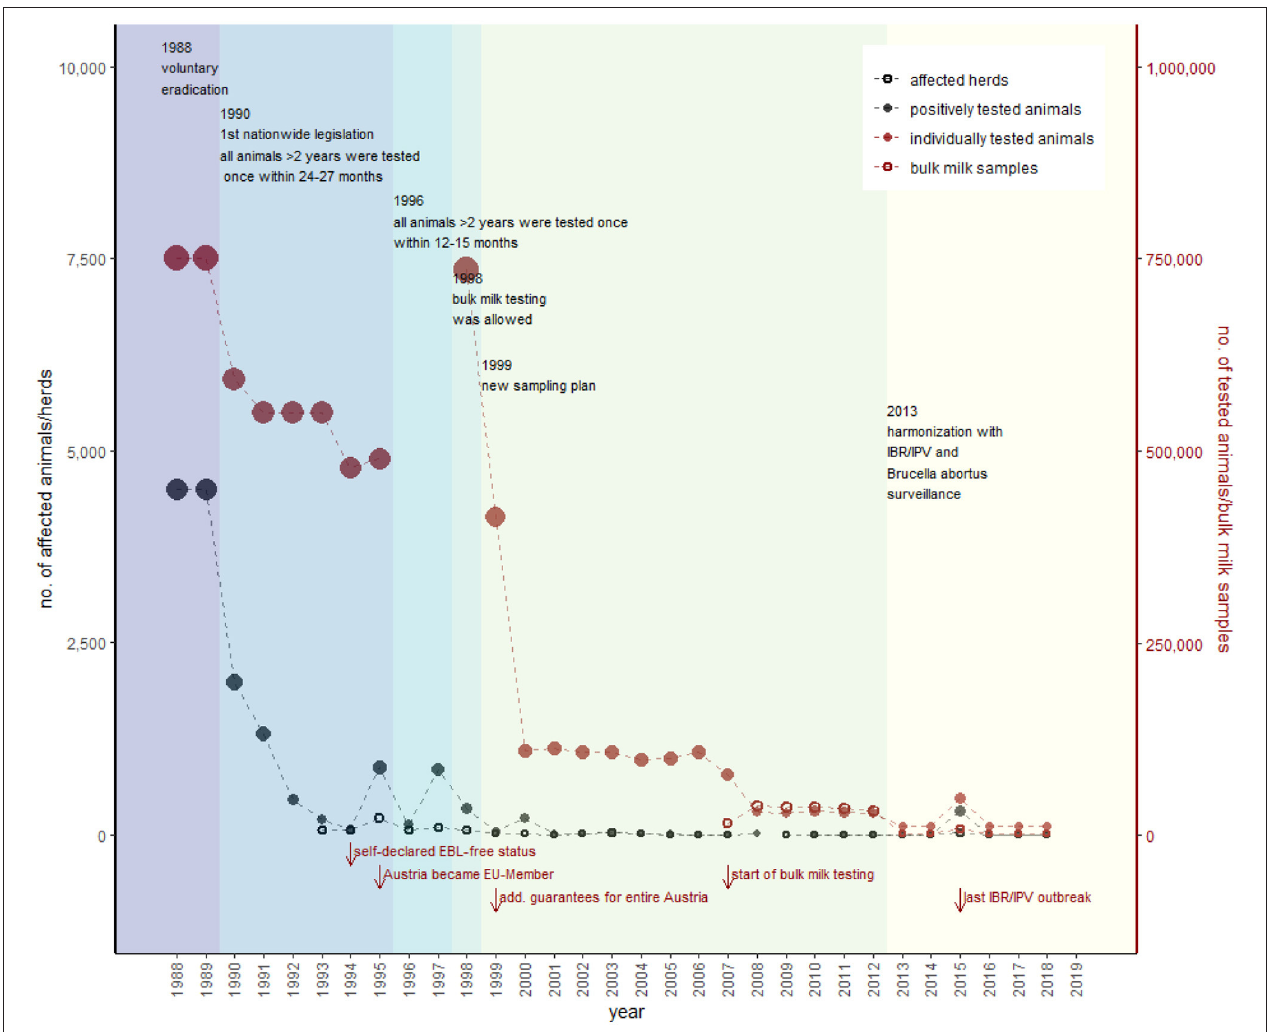
FIGURE 4 | Overview of the historical development of IBR/IPV control in Austria. Black dots represent the number of positively tested animals (filled) and number of herds with at least one positively tested animal (empty), according to the primary y -axis. The red dots show the number of individually tested animals (filled) and number of herds tested via bulk milk (empty), according to the secondary y -axis (detailed data are provided in Supplementary Table 2 ). The most important changes in legislation with consequences for the sampling strategy represent the different colors within the figure. Red arrows show further essential events regarding IBR/IPV in